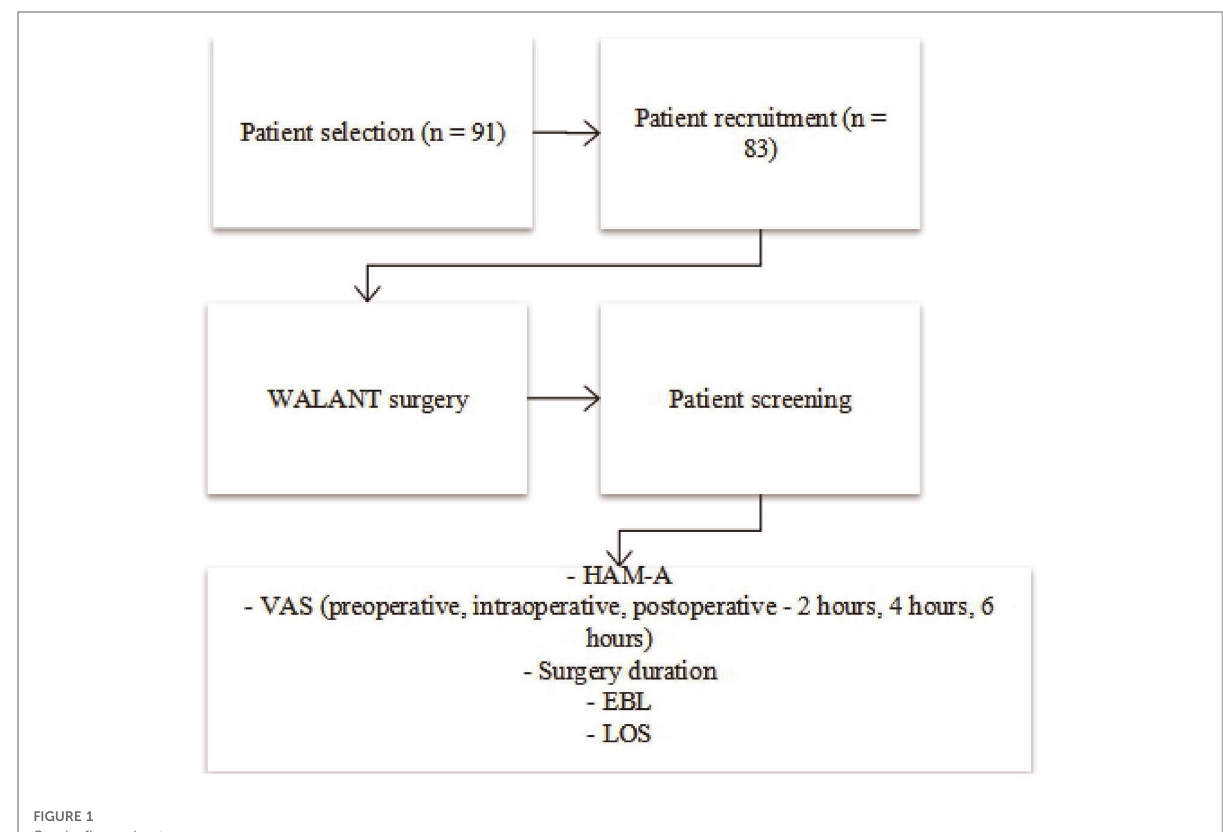
FIGURE 1 Study fl ow chart.